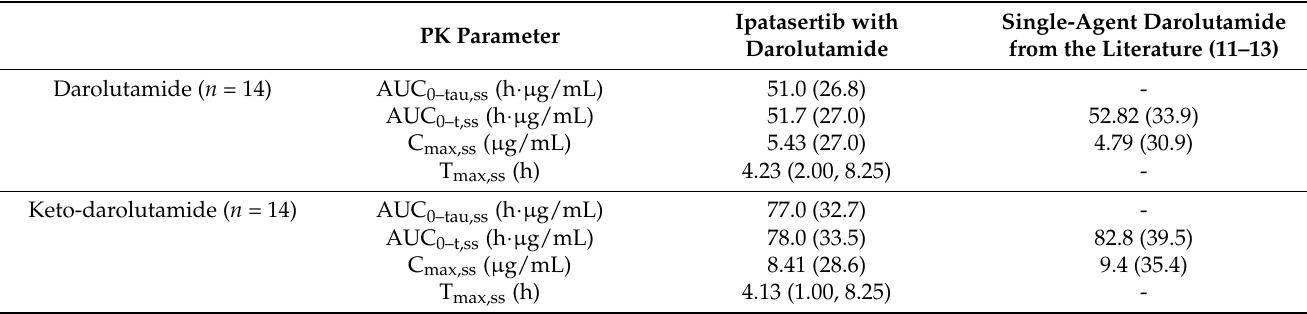
Table 4. Summary of darolutamide and keto-darolutamide pharmacokinetics following multiple-dose administration of ipatasertib 400 mg QD in combination with darolutamide 600 mg BID.